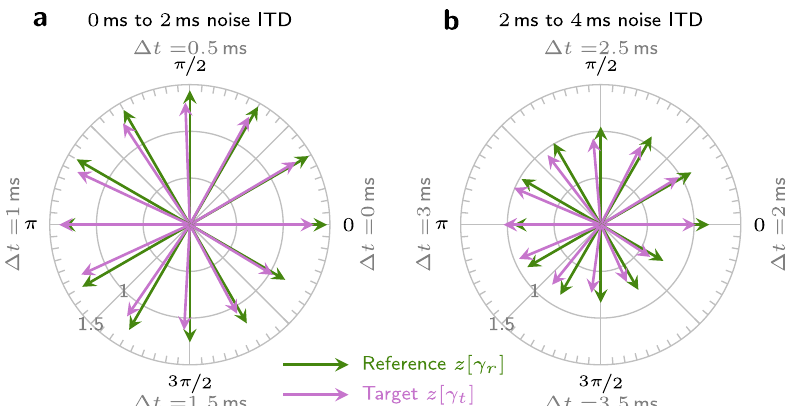
Fig. 3 Vector visualization of the z-transformed correlation coef fi cients. The fi gure shows results for selected stimuli of the N Δ t S π ) condition of van der Heijden & Trahiotis 3 (also see Fig. 2). Results for reference stimuli are shown in green while target stimuli are shown in purple. The length of each vector represents the z-transformed coherence of the respective stimulus, while the angle represents the mean IPD. Target stimuli, shown in purple, contain both tone and noise at the experimental threshold SNR. Noise-ITDs in the range of 0 – 2 ms are shown in panel a and 2 – 4 ms in panel b . Changes in Δ t are directly re fl ected by the average noise IPD, which determines the polar angle of the reference, so polar-labels state both the angle and the respective noise ITD. The distance between the tips of the reference and target vectors is directly proportional to the strength of the binaural